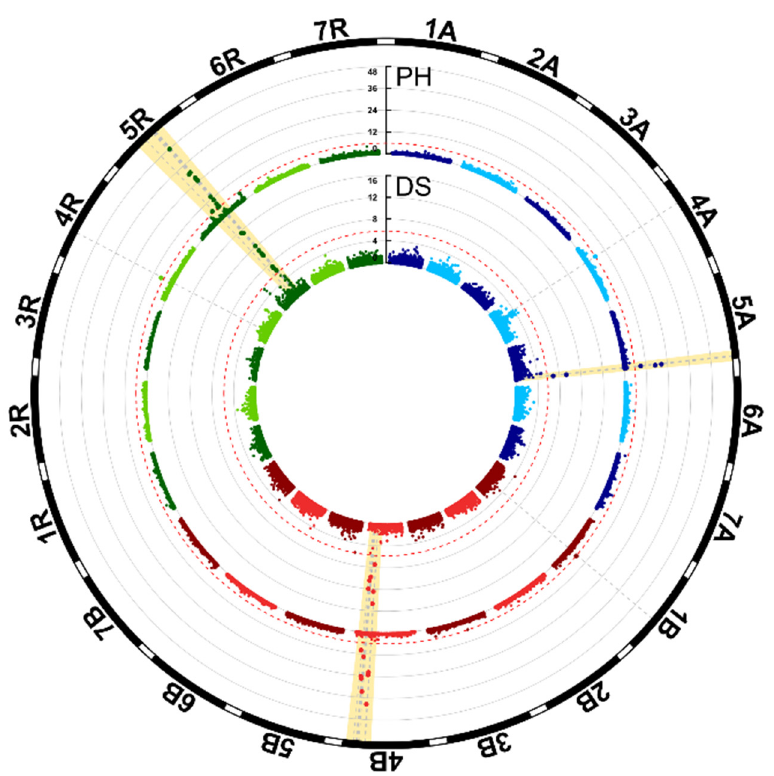
Figure 2. Circular Manhattan plot for plant height (PH) and developmental stage (DS). The red dashed lines indicate the Bonferroni-corrected significance threshold ( p < 0.05) and the shaded area the QTL with pleiotropic effects on both traits. Table 2. Results of the genome-wide association mapping for plant height and developmental stage.